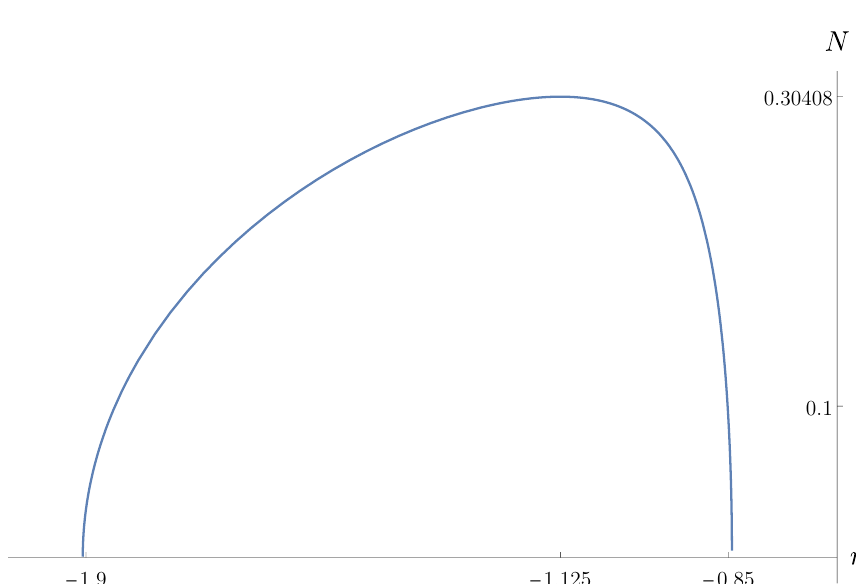
Figure 12 . Number of e-foldings N as a function of the parameter r , for the one-flux solutions ϕ 6 = 0 . There is a restricted range permitting transient acceleration, and the maximal value is reached for r = − 9 , giving N = 0 . 30408 max max 8